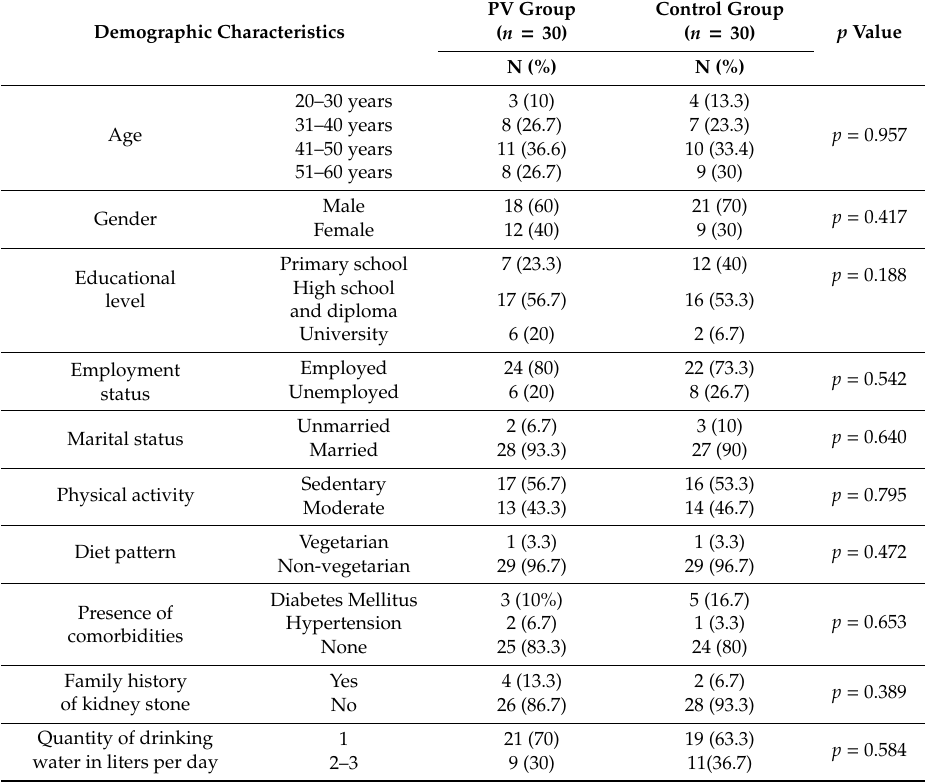
Table 1. Reporting baseline demographic characteristics of intervention and control